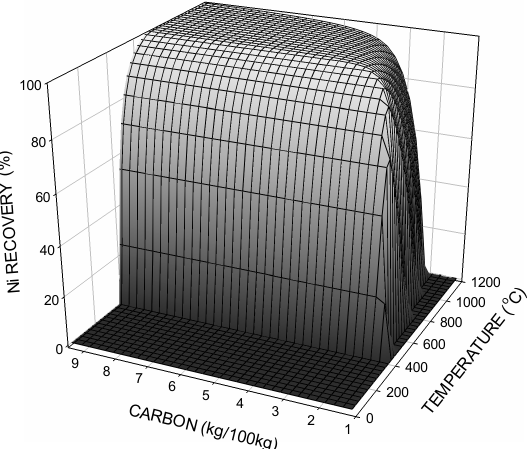
Figure 2. Effects of temperature and carbon additions on the nickel recovery for the limonitic ore.